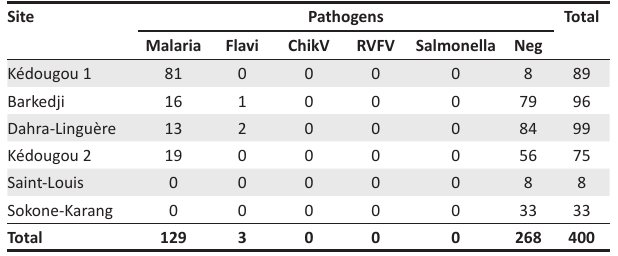
TABLE 1: Distribution of blood samples collected and pathogens identified in Kédougou, Barkedji, Dahra-Linguère, Saint-Louis and Karang-Sokone areas, October 2017–March 2018.